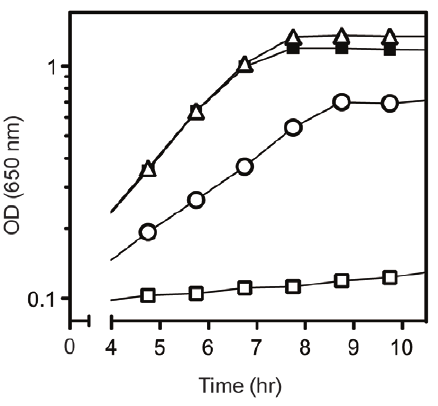
Figure 1. Mutations in dapA restore growth to ridA mutants in the presence of serine. Growth was monitored over time as optical density at 650 nm. Strains were grown at 37 u C in minimal glucose medium with no additions (closed symbols) or 5 mM serine (open symbols). Shown are strains ridA (DM3480), squares; ridA dapA356 (DM11637), triangles; and ridA dapA360 (DM11640), circles. Curves displayed were representative of 3 biological replicates.